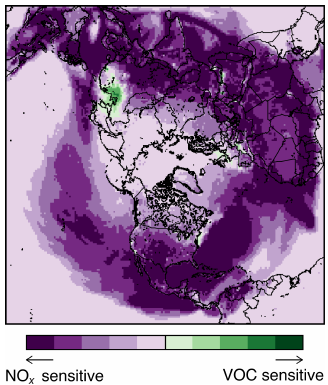
Figure 2. Spatial distributions of the ozone-sensitive regime during April